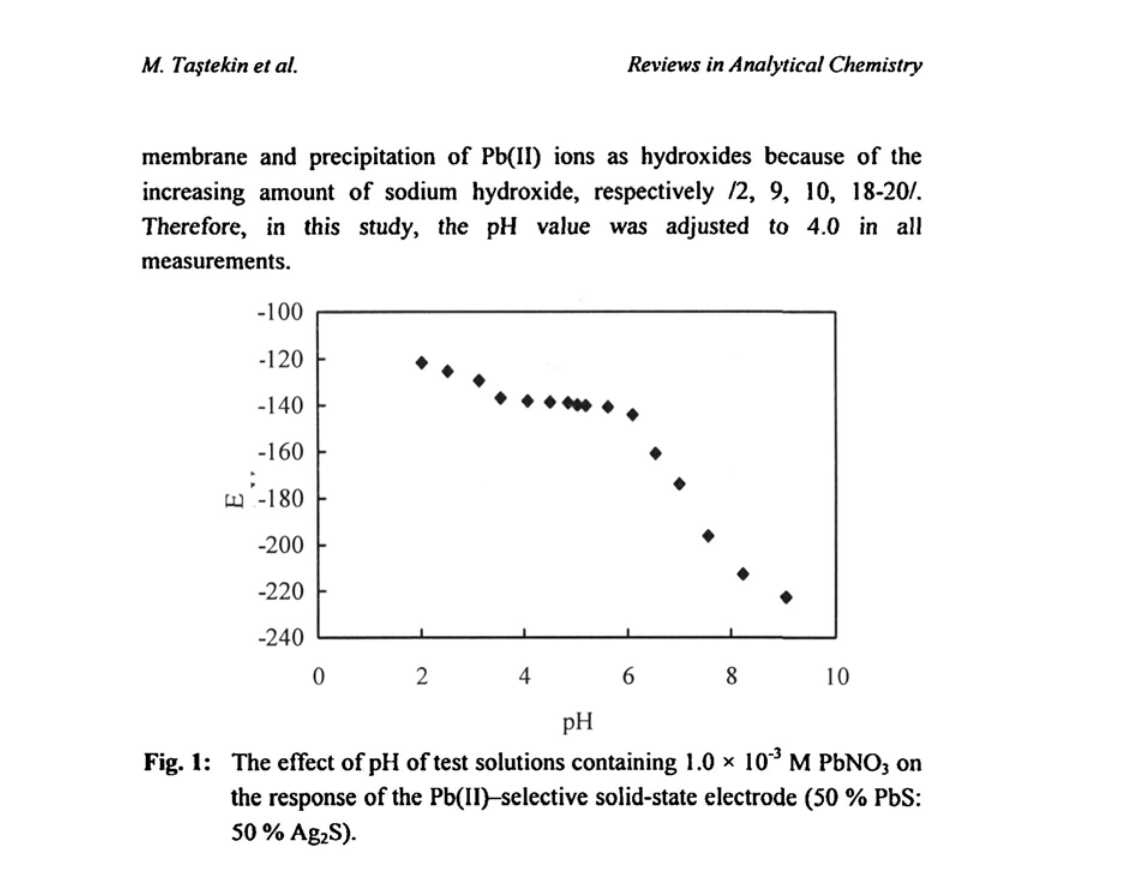
Fig. 1: The effect of pH of test solutions containing 1.0 χ ΙΟ" 3 Μ PbNO the response of the Pb(II)-selective solid-state electrode (50 % PbS: 50 % Ag 2